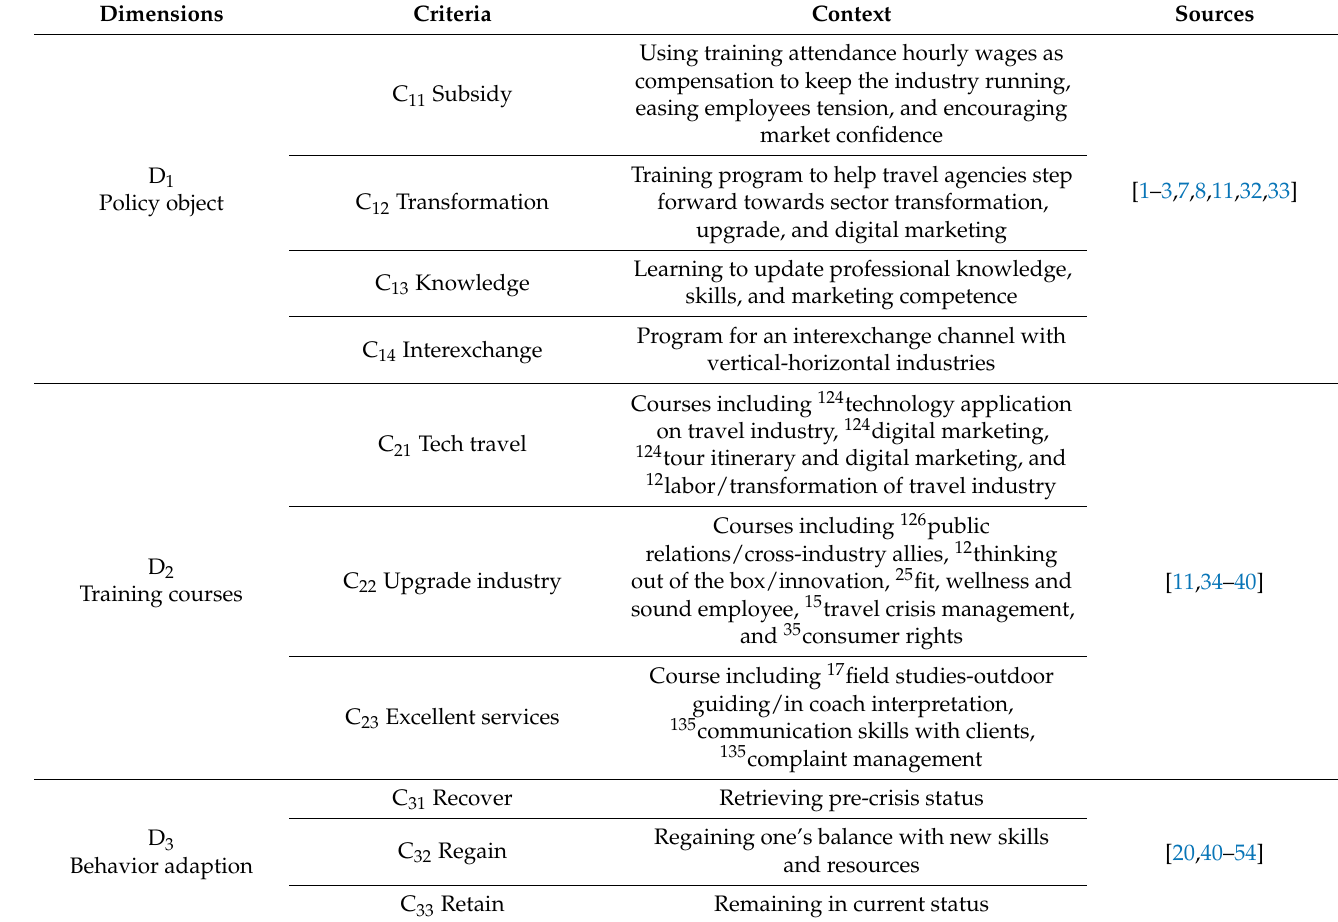
Table 1. The dimensions and criteria of the paid training